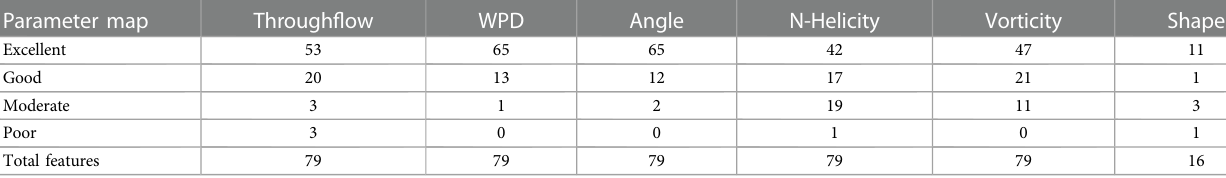
TABLE 3 Number of features grouped by inter-observer agreement and underlying parameter map and contour shape feature type. Reproducibility thresholds were adopted from Koo and Li (25). The majority of the features show an excellent or good agreement for all parameter